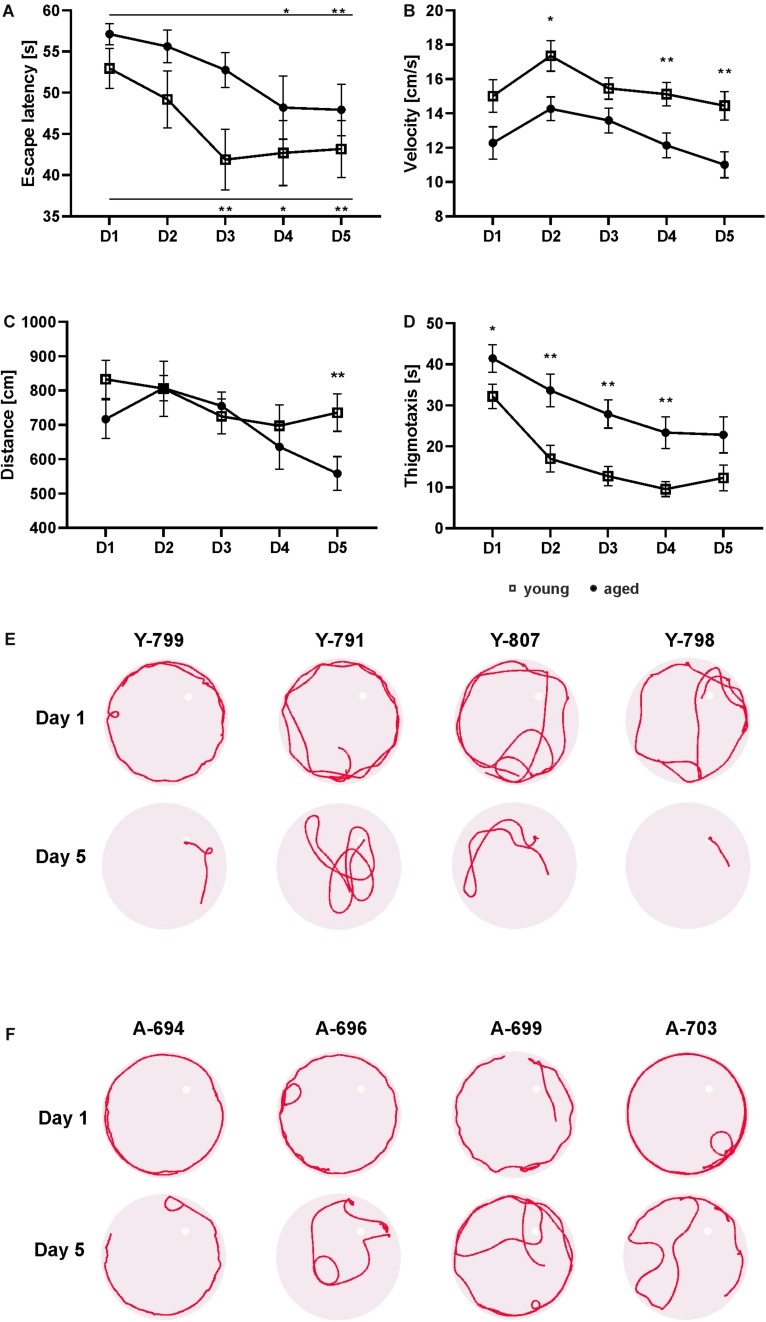
Behavior of young and aged opossums in the Morris water maze test during training. The young group consisted of 14 male opossums with an average age of 6.5 months, while the old group consisted of 14 opossums with an average age of 21.5 months, of which two were female. Both groups of opossums decreased the escape latency during five consecutive learning days (A). The total distance traveled by young and aged opossums was the same during 4 days training, although on the last day the young opossums traveled a significantly longer distance than the aged opossum (C). The swimming velocity (B) and the thigmotactic responses (D) were also different. In (A–D) squares refer to young opossums and circles refer to aged opossums. (E,F) Swimming path lengths for four young and four aged opossums on training day 1 and day 5. A small circle shows the placement of the hidden platform. The opossum number is at the top of each circle. Y, young; A, aged. ∗p < 0.05, ∗∗p < 0.01.